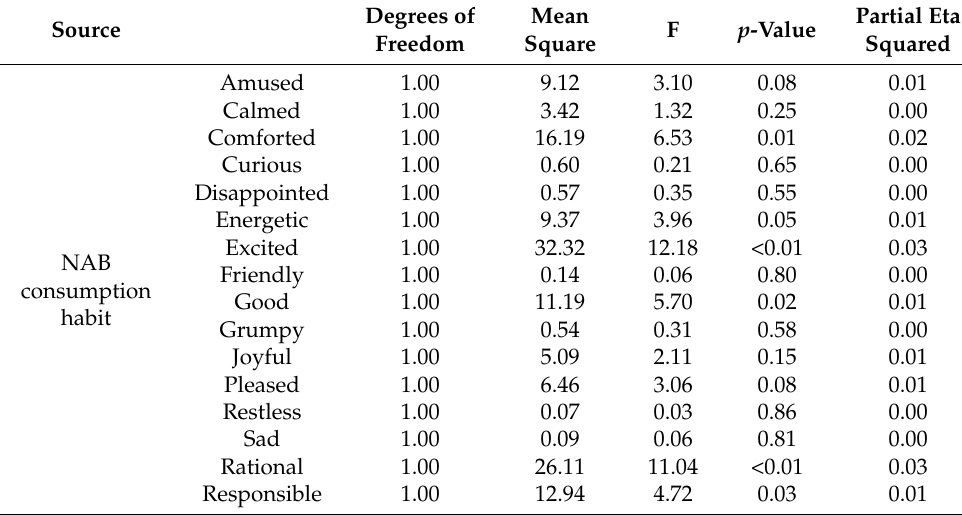
Table 6. Summary of the results of the univariate tests at the between-participants level on each emotion score in Experiment